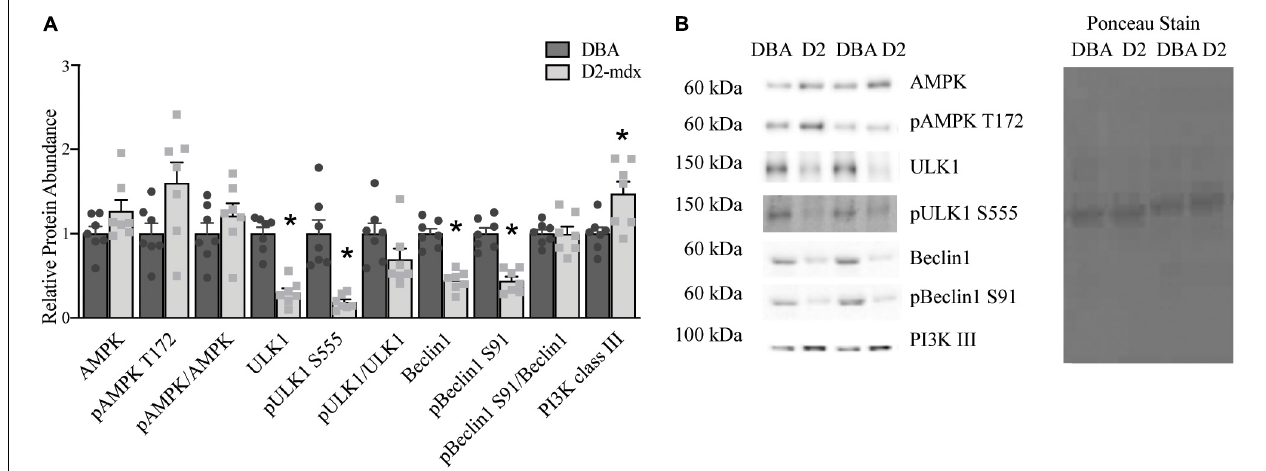
FIGURE 3 | Markers of autophagic activation analyzed in a cytosolic fraction from gastrocnemius muscles. Western blot analysis of activation markers of autophagy in a cytosolic fraction from gastrocnemius muscles from 11 month old D2-mdx and DBA mice. (A) ULK1, pULK1 S555, Beclin1and pBeclin1 S91 were decreased,